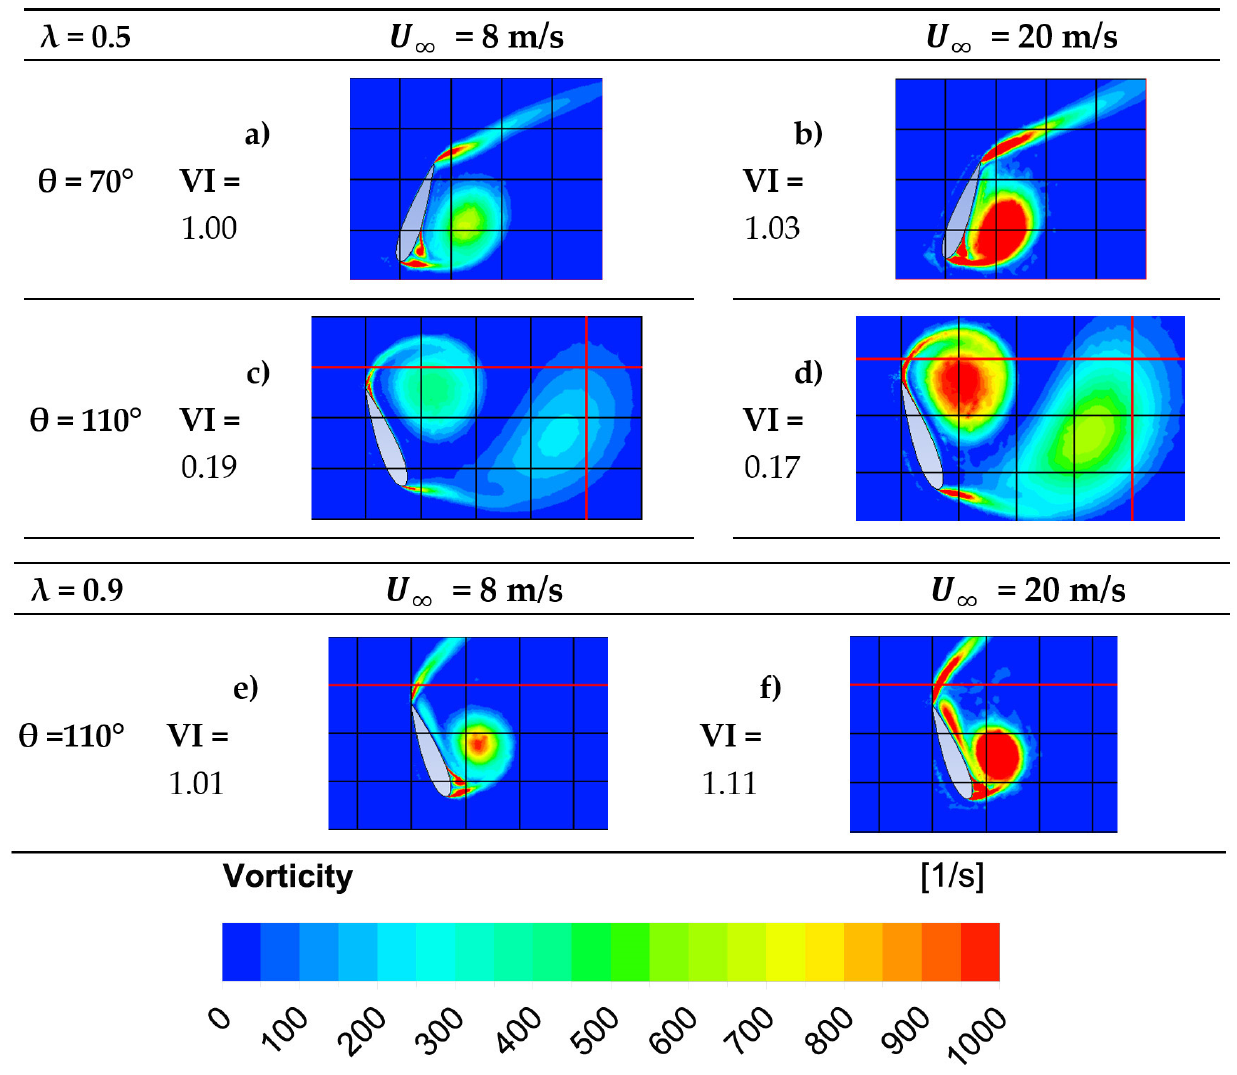
Figure 22. Vorticity Contours for Imminent Vortex Separation Condition (IVSC) for 𝑈 (cid:2998) = 8 m/s and for 𝑈 (cid:2998) = 20 m/s, at ( a–d) 𝜆 = 0.5 and ( e ‐ f ) 𝜆 = 0.9.